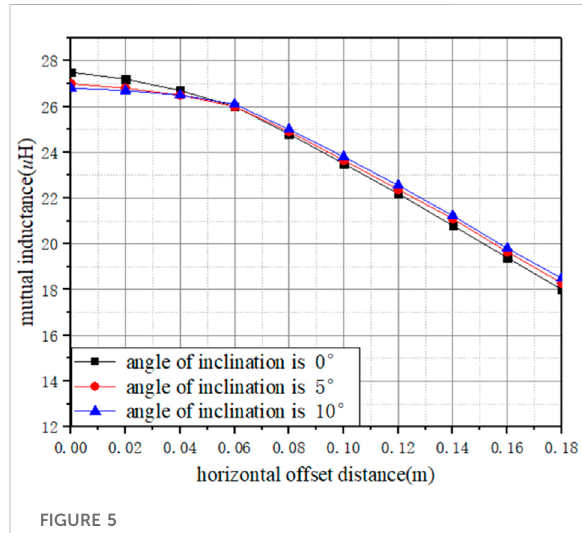
FIGURE 5 The mutual inductance offset characteristics of MTMR